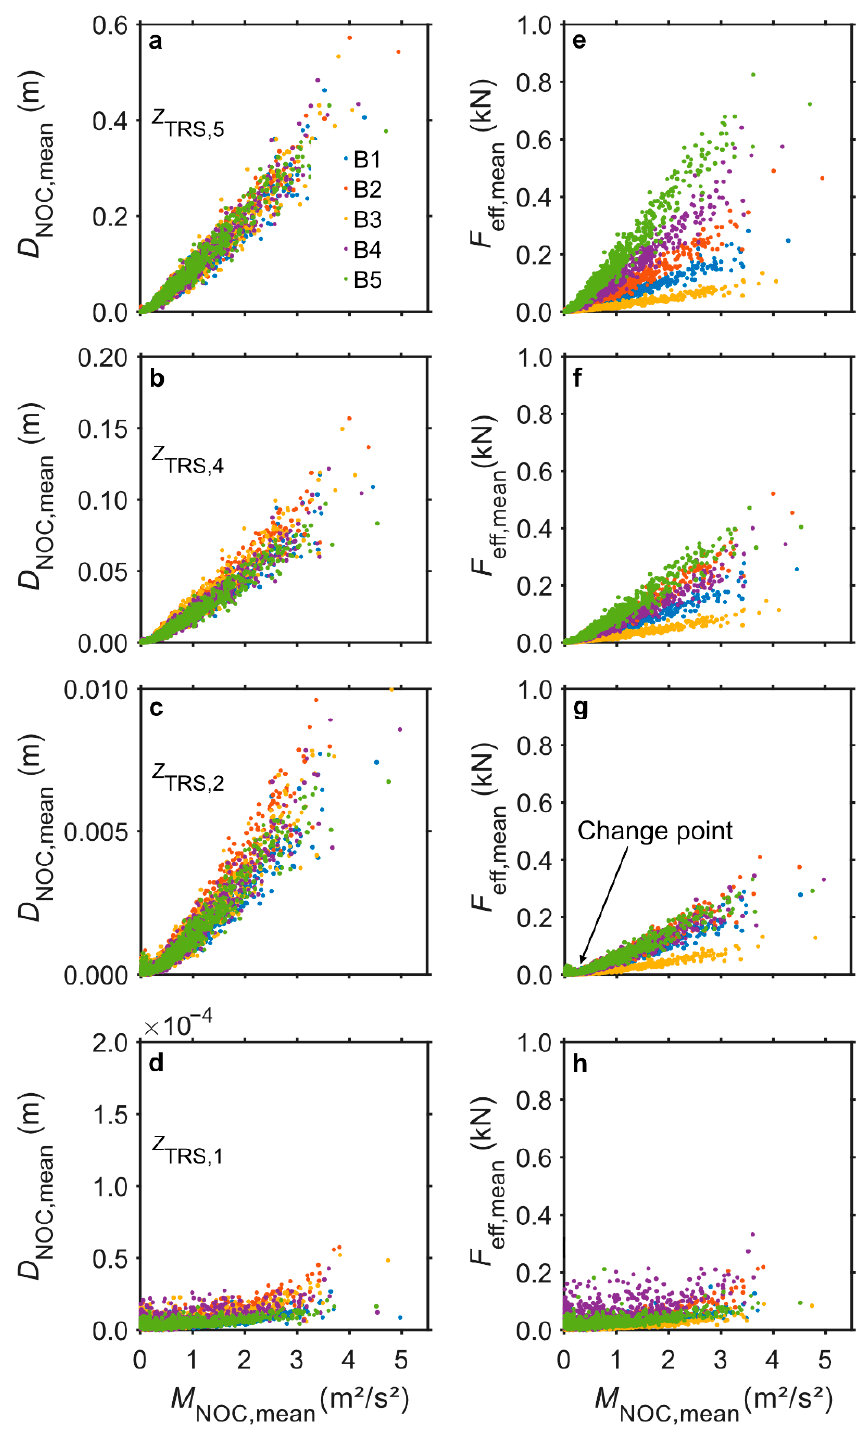
Figure 6. Dependence of 10 min mean values of non-oscillatory stem displacement ( D NOC,mean ) on low-pass filtered momentum flux ( M NOC,mean ) at heights ( a ) z TRS,5 = 5/7 H , ( b ) z TRS,4 = 3/7 H , ( c ) z TRS,2 = 1/7 H , and ( d ) z TRS,1 = 0.1 m. Dependence of 10 min mean effective force ( F eff,mean ) on M NOC,mean at ( e ) z TRS,5 , ( f ) z TRS,4 , ( g ) z TRS,2 , and ( h ) z TRS,1 along the stems of B1 to B5. The arrow in ( g ) highlights the point where the response of B1 to B5 to wind loading systematically